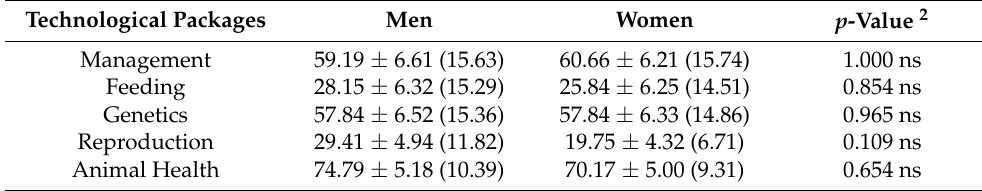
Table 3. Descriptive statistics for technological packages (Mean ± SD (CV, %) 1 ). Technological